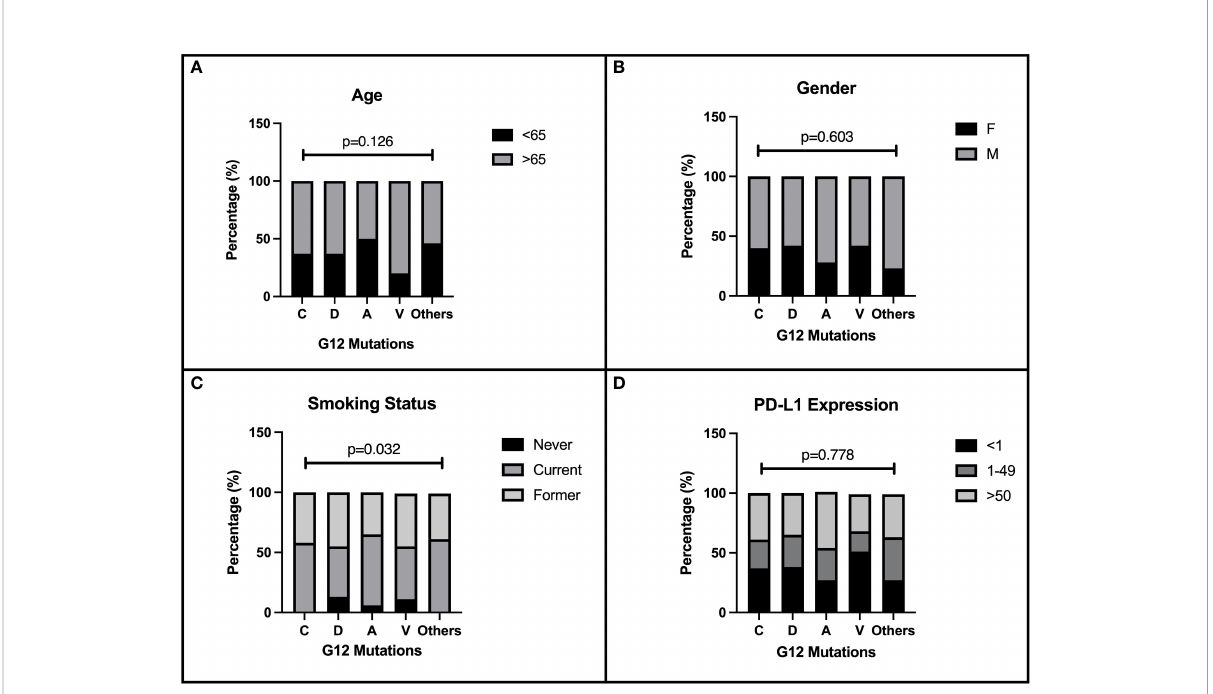
FIGURE 1 Correlation of patients ’ characteristics and G12 bases. Baseline characteristics of 219 NSCLC patients enrolled in the present retrospective study. The distribution of demographic and immunohistochemical properties is shown in fi gure according to the single amino acid mutation. The distribution of G12 isoforms was correlated to: (A) age of patients at diagnosis (< 65 and ≥ 65 years), p=0.126. (B) gender p=0.603. (C) smoking habits p=0.032. (D) PD-L1 expression,